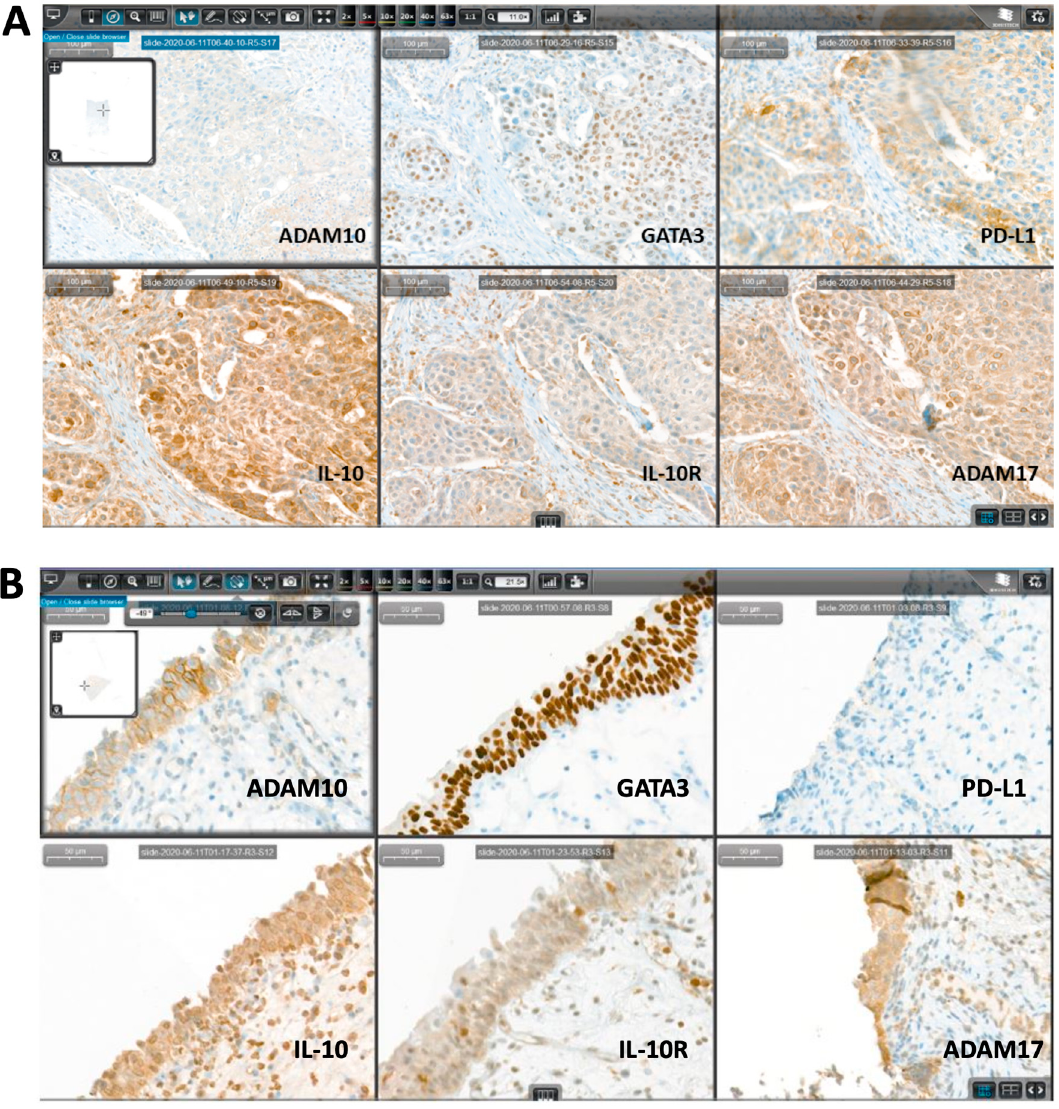
Figure 1. Representative immunohistochemical (IHC) figures of the complete IHC panel stained on consecutive sections using CaseViewer digital microscopy for systematic analysis. The presented cases show a pT2b urothelial carcinoma ( A ) and a primary carcinoma in situ (CIS) ( B ) on radial cystectomy (RC) specimen.